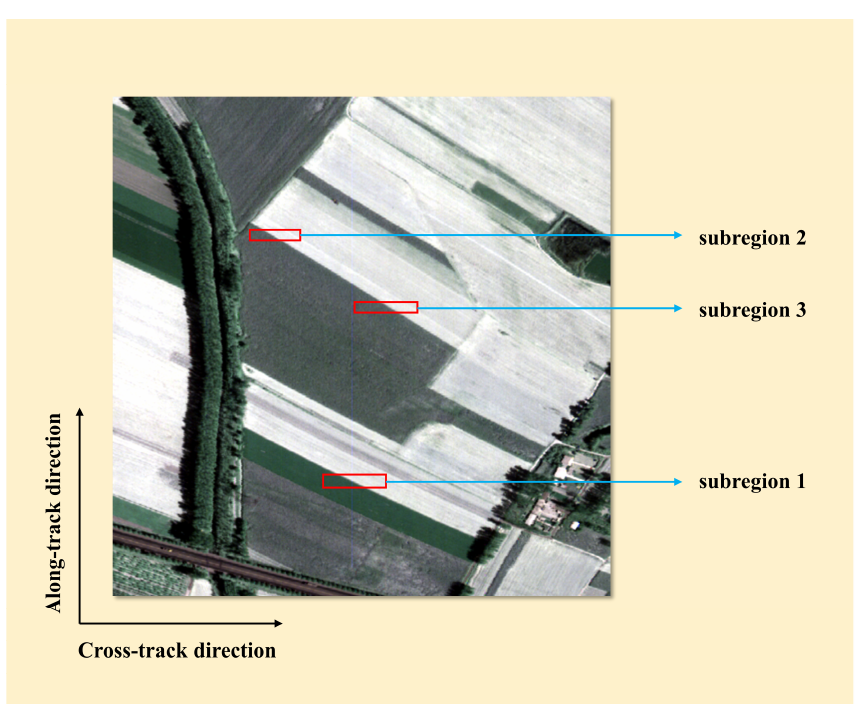
Figure 9. Pseudo-color image of the selected subregions.